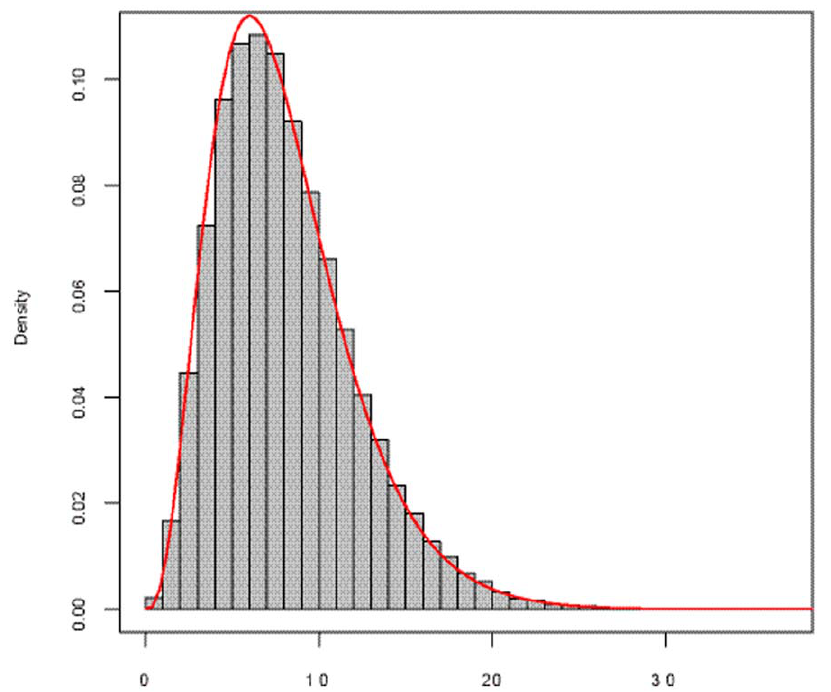
Figure 2. Frequency histogram of 2000 6 MI based on 10,000 simulations, compared with x 2 (8). The gray bar denotes the frequency histogram of 2000 6 MI , corresponding to the null hypothesis that two SNPs are of no interaction. The red line is the density curve of x 2 (8).